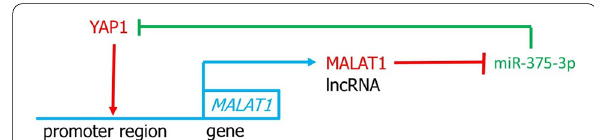
Fig. 4 Hypothetical feedback between lncRNA MALAT1 and YAP1 via miR-375-3p enhancing MALAT1 gene